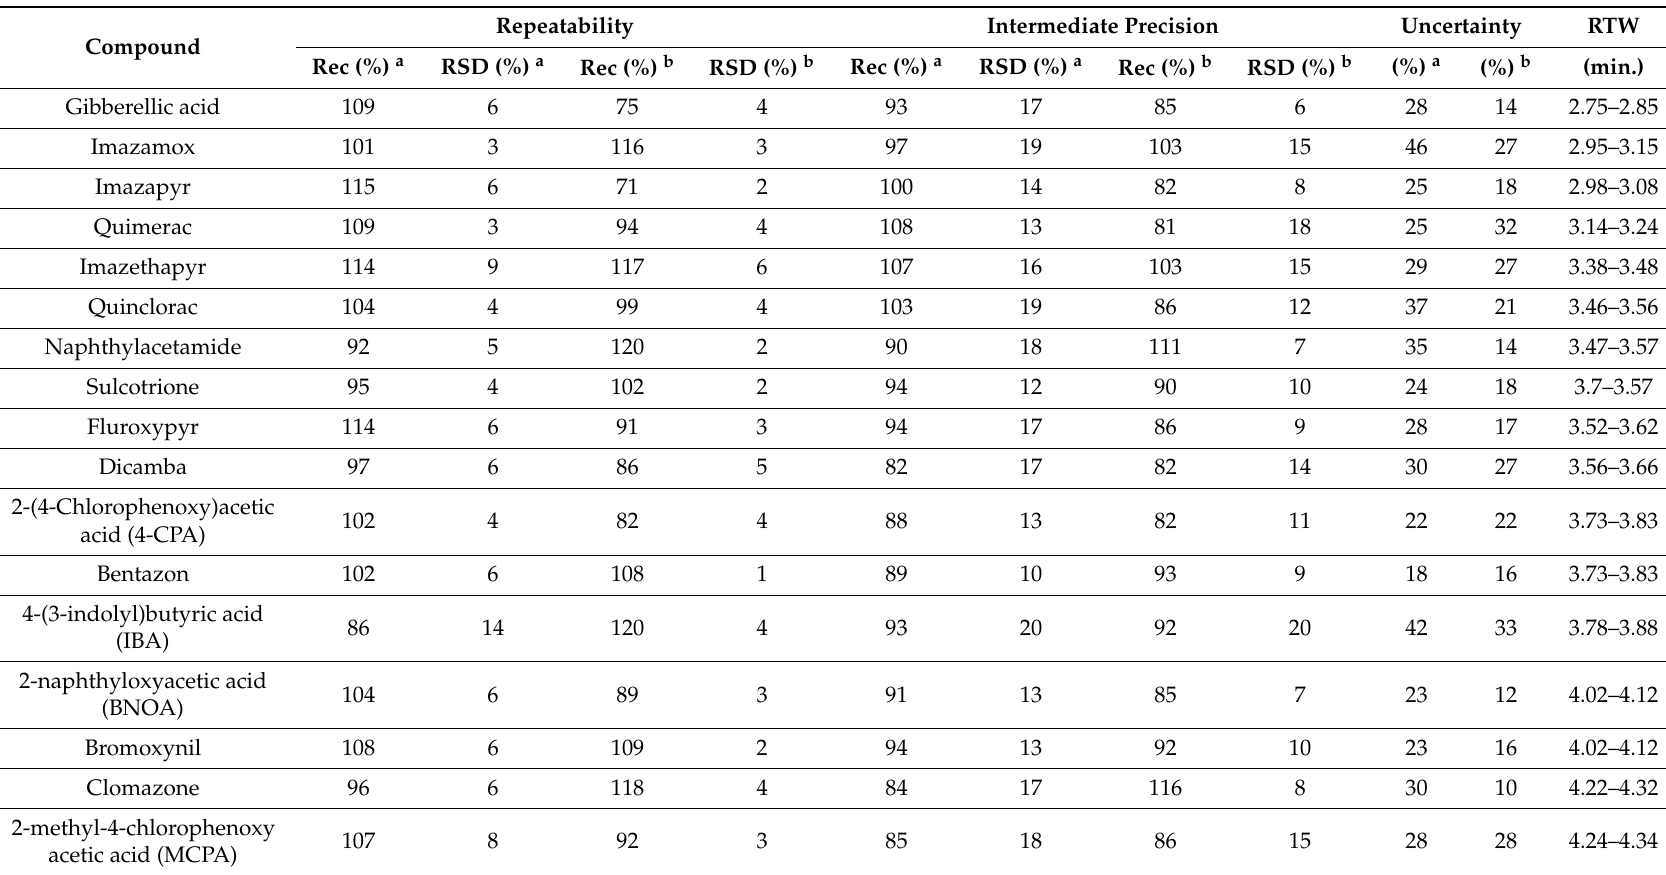
Table 2. Retention time windows and validation parameters for the target compounds in